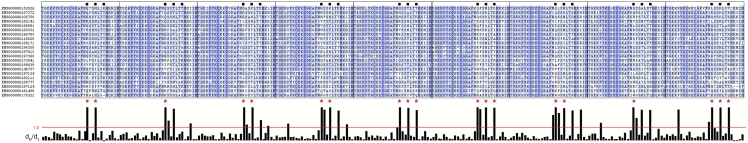
Example Poly-ZF Alignment.A protein multiple alignment of the largest human poly-ZF gene expansion, with some sequences removed for clarity (see Methods). Columns with any gaps have been removed. The 9 zinc fingers included in the alignment are outlined in black boxes, and black squares mark the three major nucleotide specificity residues (positions −1, 3 and 6) in each zinc finger. The darkness of the blue background is proportional to amino acid conservation. Below is plotted the posterior mean dN/dS value assigned by Bayes-Empirical-Bayes analysis at each position. The red line represents dN/dS = 1 (no selective pressure), and red stars mark residues at which the hypothesis dN/dS>1 reaches statistical significance (P> = 0.95).